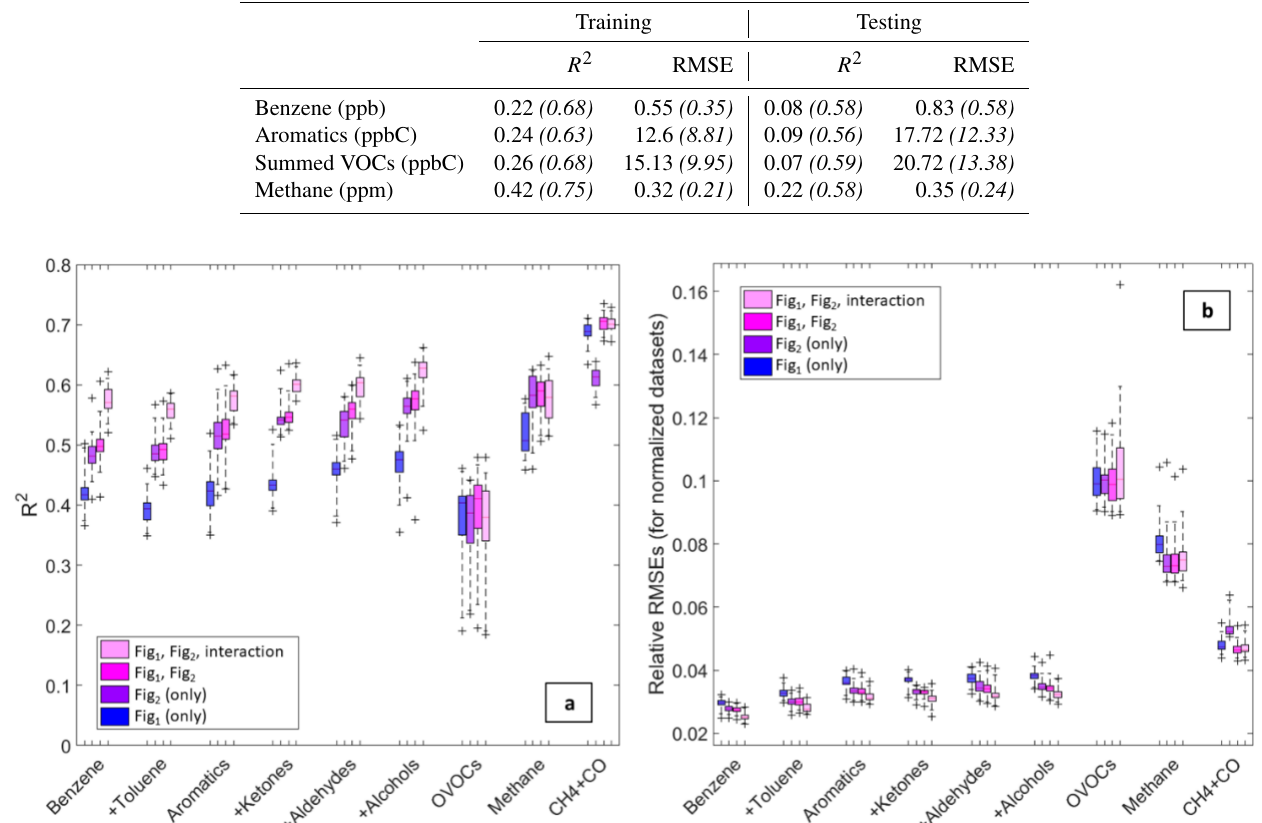
Figure 9. The box plots above illustrate the results of training on a randomly selected 15% of the data and testing on the remaining 85% 25 times, using each sensor individually, the two sensors as predictors, and the two sensors plus an interaction between them. Panels (a) and (b) depict the R 2 and RMSE, respectively, for the testing data. Note all of the data have been normalized and the whiskers are the fifth and 95th percentiles. The x axis indicates the VOC or group being